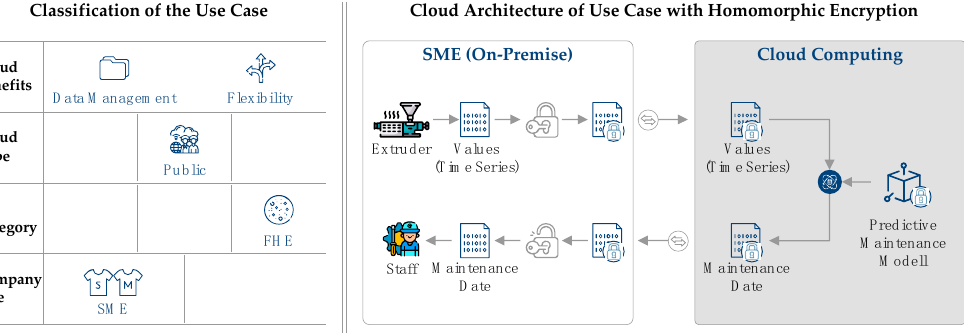
Figure 7. Classification and cloud architecture for predictive maintenance of an extrusion process.